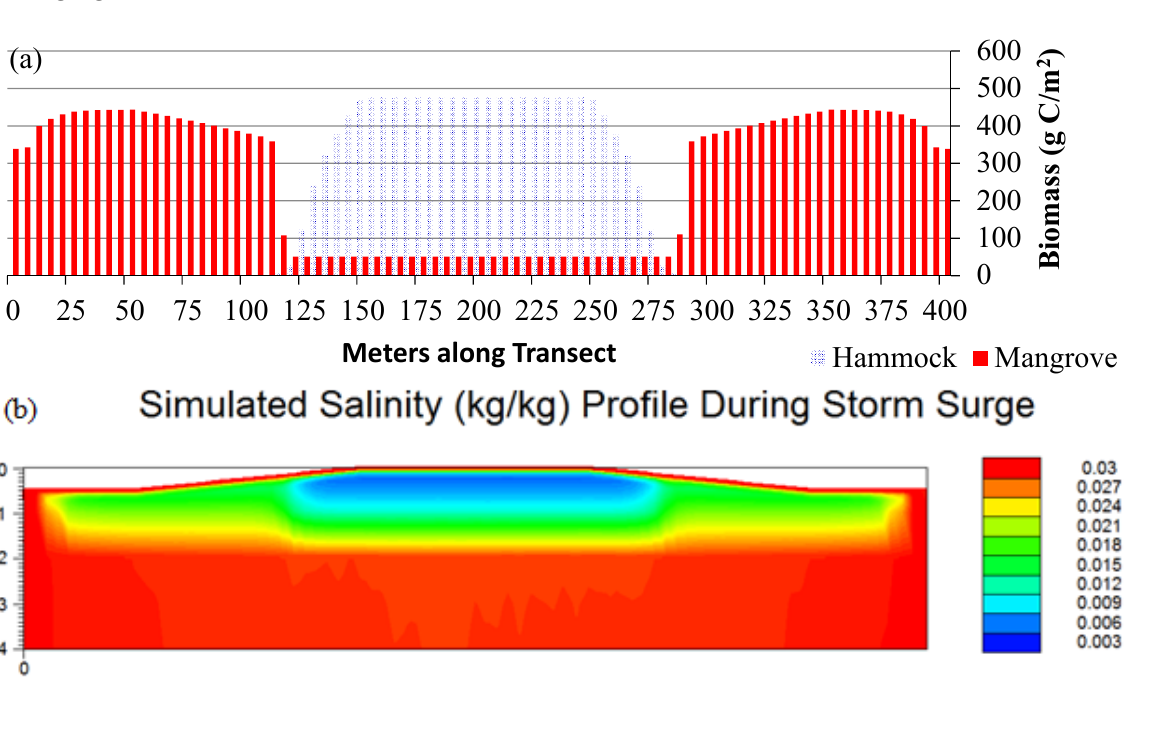
Figure 4. ( Top ) Simulated distribution of mangroves (red) and hardwood hammock (blue) trees along a 370-meter transect (rounded to 400 m in the model) across the Coot Bay Hammock. ( Bottom ) Simulated salinity profile with ground depth in meters and salinity in kg/kg.